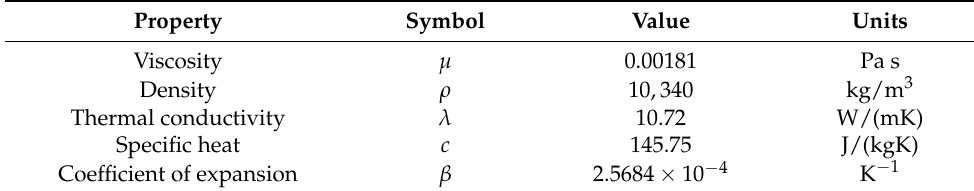
Table 1. Boussinesq control: physical properties employed for the numerical simulations.